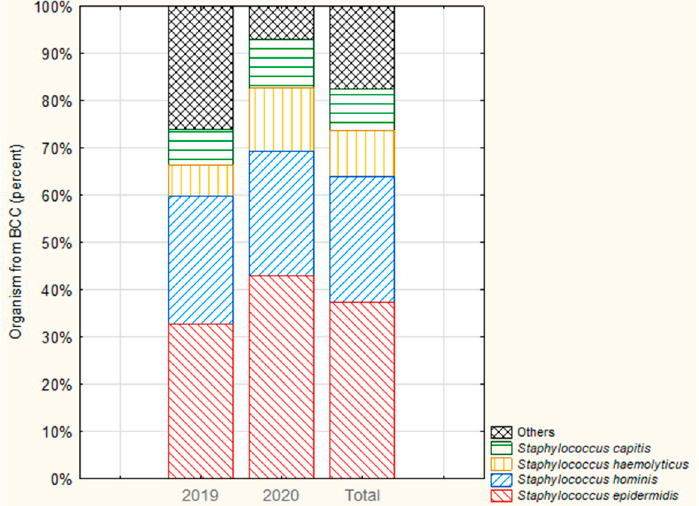
Figure 3. Distribution of the four most prevalent organisms isolated from blood culture contamina- tion (BCC) in 2019 and 2020.